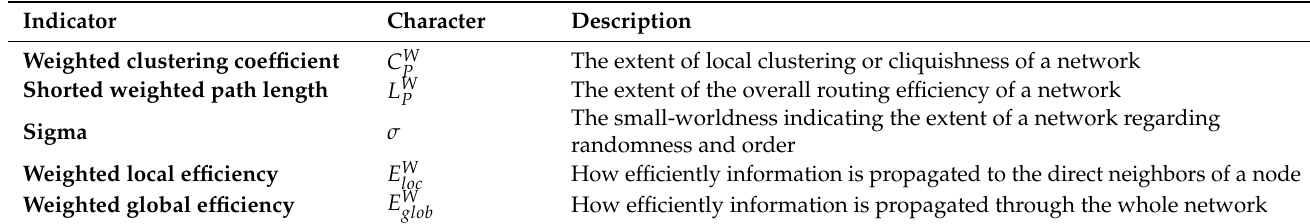
Table 1. Brief descriptions of complex network indicators in this paper.